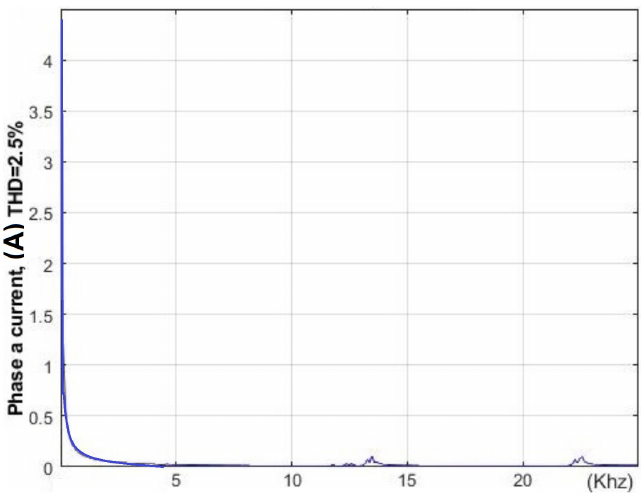
Figure 19. Phase A current at a high-load situation with f C = 24 kHz and THD =